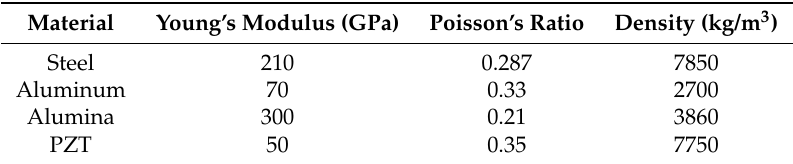
Figure 3. ( a ) Schematic of measurement for the scattering transducer in the center of the array by using the symmetry in this case with one source and 13 monitor points; ( b ) cross section of modeled transducer, the scattering transducer, in finite element (FE) model; ( c ) scattered wavefield obtained by subtracting the incident wavefield of the FE simulation with and without the scatterer in measured point 1; ( d ) scattered wavefield obtained from the experiment in measured point 1 and ( e ) the normalized amplitude varying with the measured points in the simulation and the experiment. Table 1. Material